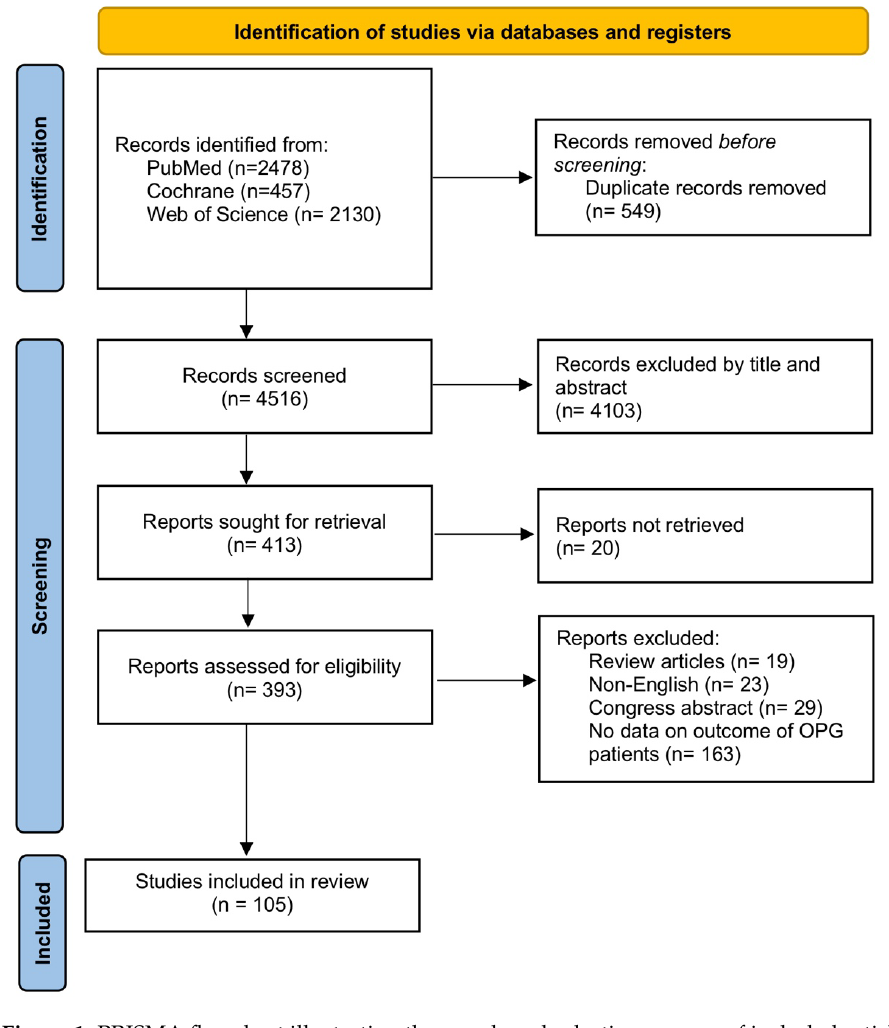
Figure 1. PRISMA flowchart illustrating the search and selection process of included articles.